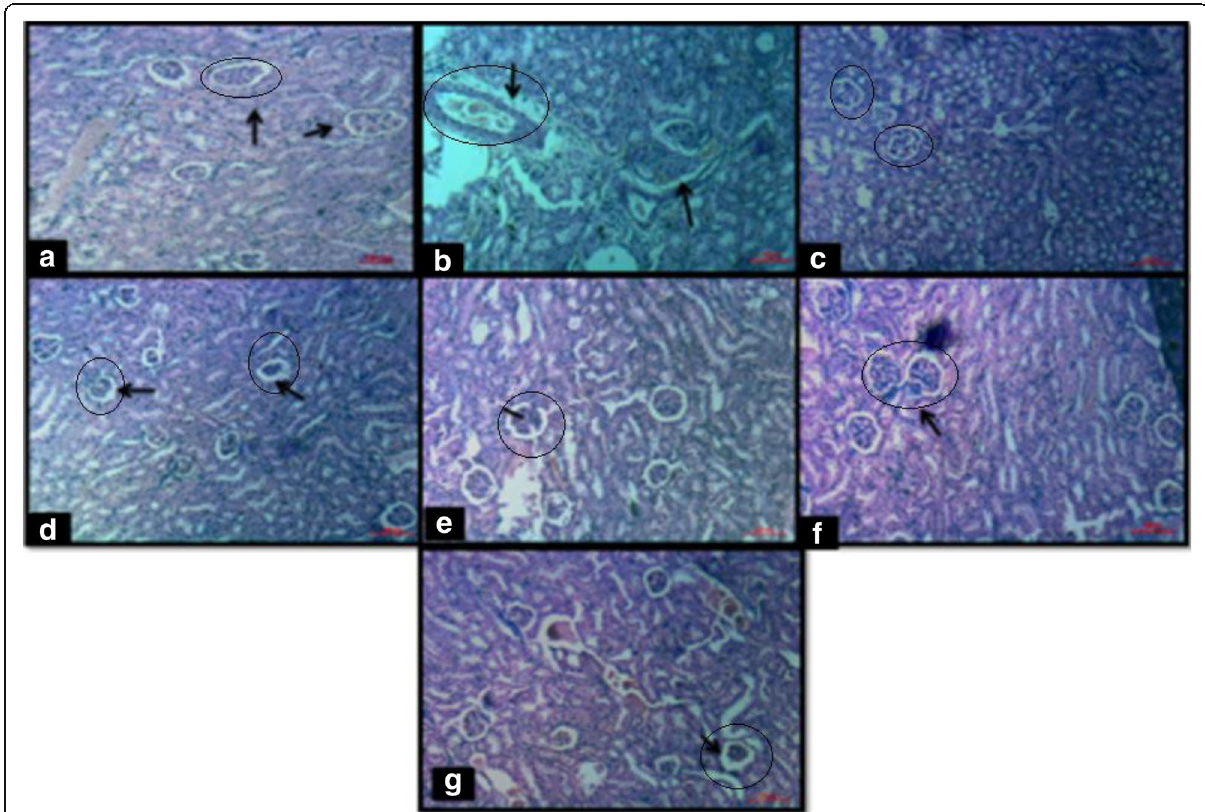
Fig. 6 Histological alteration in the kidney (H&E staining 100×) photomicrograph of kidney tissue. a . Control b . Only(STZ). c . STZ and Glibenclamide. d . STZ and 0.5%Eucalyptus oil (EO) e . STZ & 1% (EO), f .STZ & 1.5% (EO), g . STZ & 2% (EO). Scale bar of 100 μ